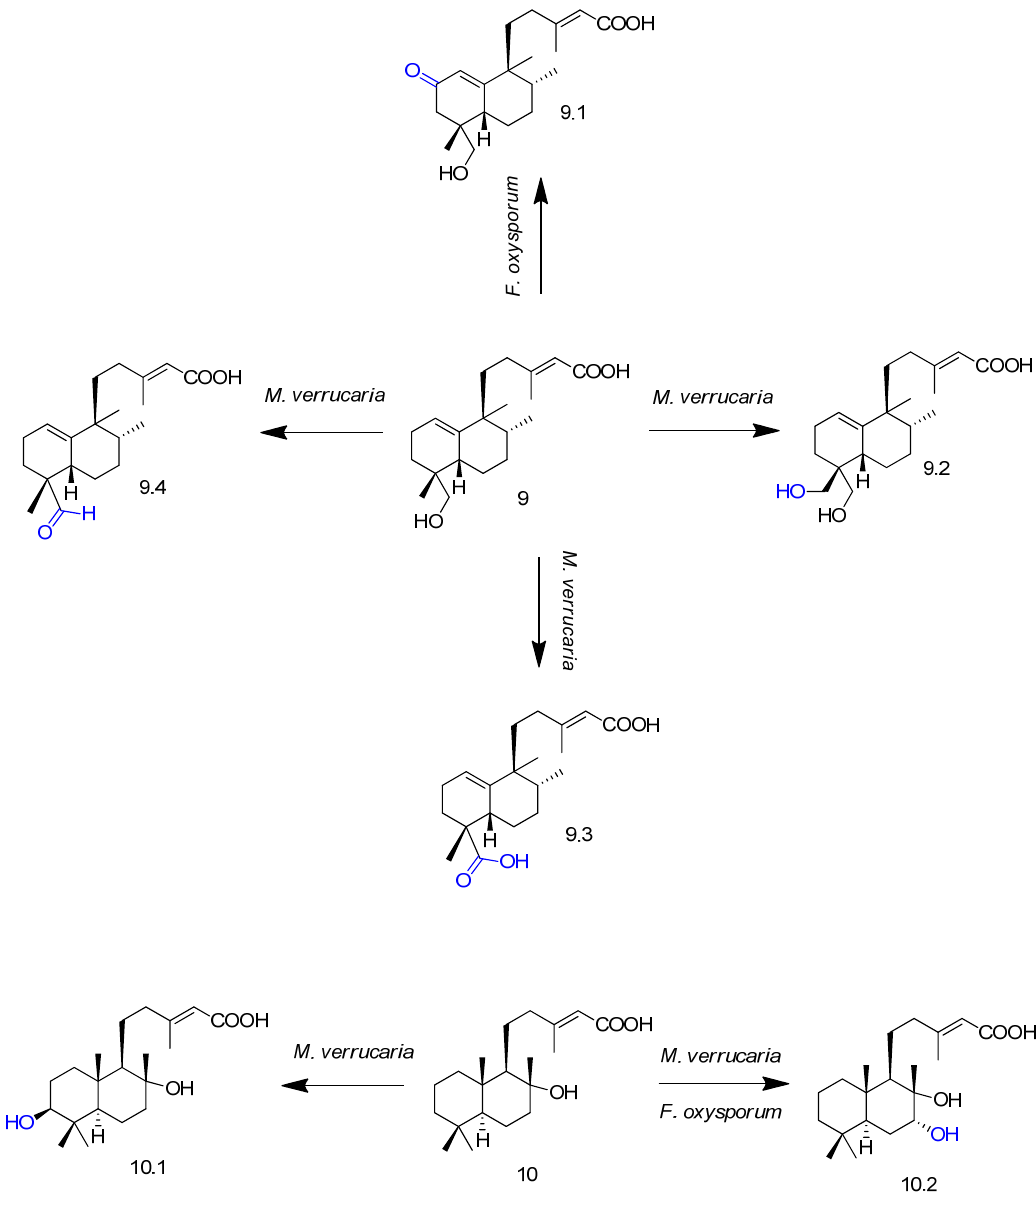
Figure 11. Diterpenoids 9 and 10 and their derivatives obtained by Fusarium oxysporum and Myrothecium verrucaria biotransformation [55].